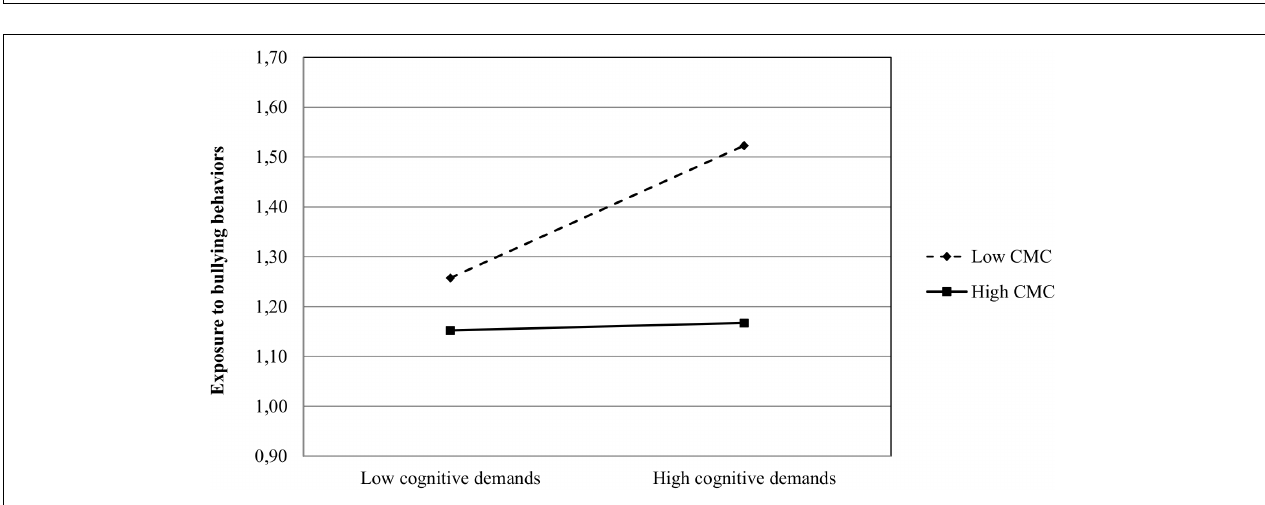
FIGURE 1 | Plot of the interactive relationship of role conflict and bullying behaviors in teams with weak vs. strong CMC. CMC, conflict management climate.